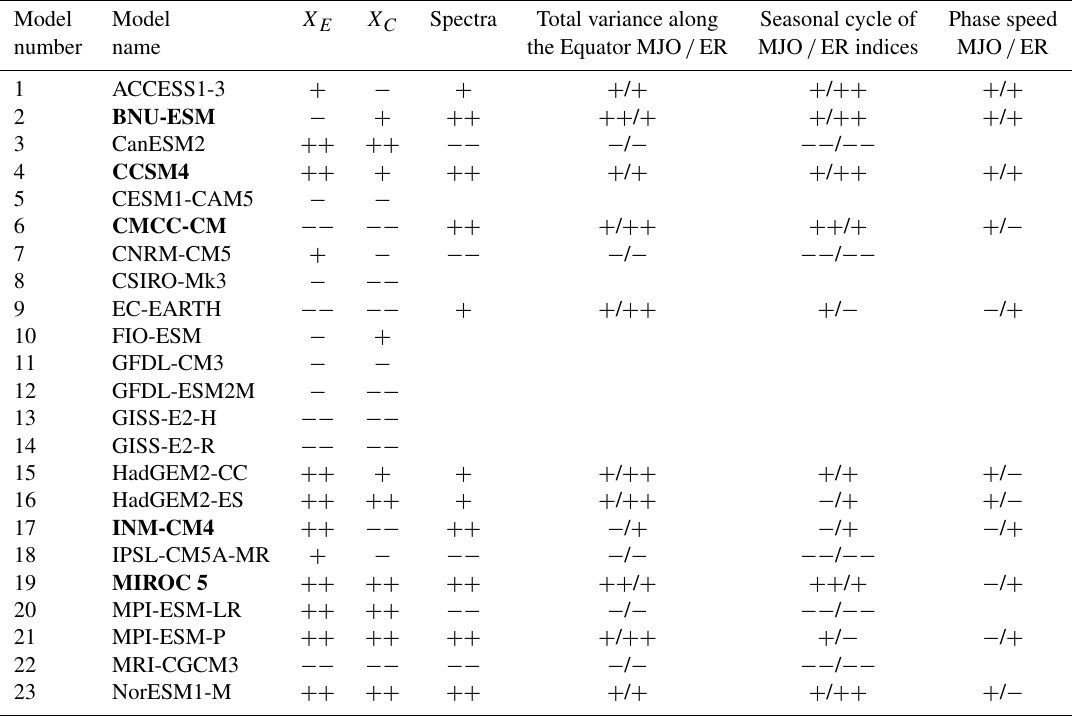
Table 3. Summary of the model skill according to the diagnostics performed in our study. The + and − signs refer to “semi-objective” criteria which are defined in Table 4. The model names in bold are those analysed in Sect. 3.3 (i.e. seasonal ENSO / ITV relationship).